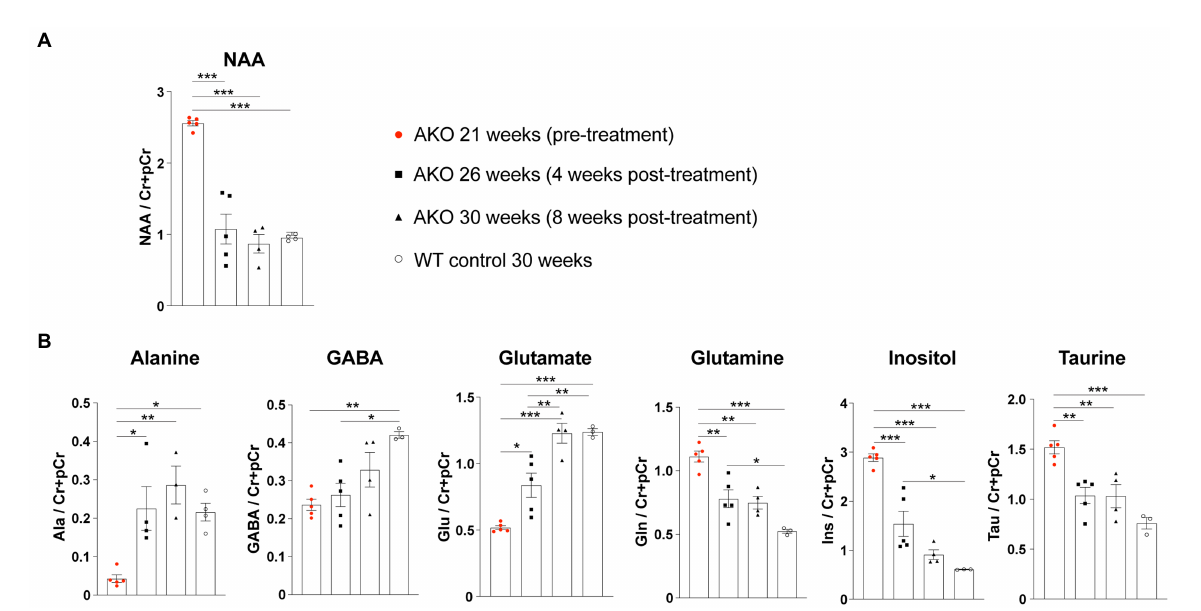
FIGURE 4 Dual function gene therapy in 22-week-old AKO mice with end-stage Canavan pathology normalizes brain metabolite levels. AAV.U6-shNat8l.1- MBP-coASPA vectors were injected bilaterally into striatum, thalamus, and cerebellum (3 × 10 9 vg per site) of 22-week-old AKO mice. 1 H-MRS was performed before as well as 4-and 8-weeks post-treatment. (A) Quantification of brain N-acetyl-L-aspartate (NAA) levels normalized to creatine and phosphocreatine (Cr + pCr) in the same group of AKO mice before and after treatment and in wildtype (WT) control mice ( n = 4–5). (B) Quantification of the metabolites alanine (Ala), gamma aminobutyric acid (GABA), glutamate (Glu), glutamine (Gln), inositol (Ins), and taurine (Tau) normalized to creatine and phosphocreatine (Cr + pCr) in the brain of AKO mice before and after treatment and in WT control mice ( n = 3–5). Data represent mean ± SEM. * p < 0.05, ** p < 0.01 *** p < 0.001; One-way ANOVA with Bonferroni post-hoc